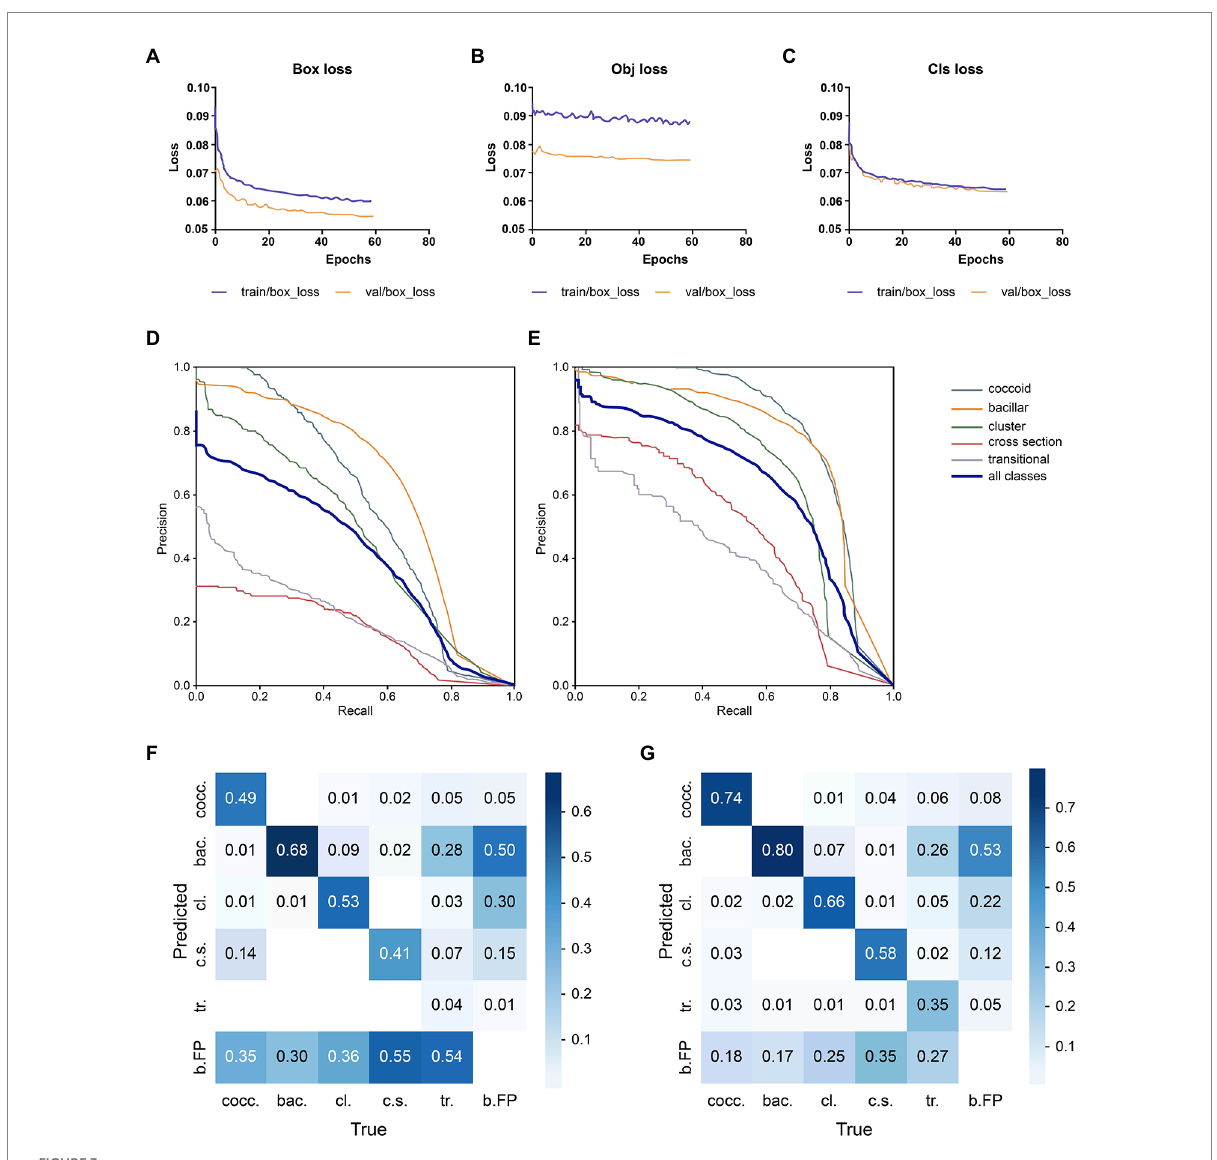
FIGURE 3 Performance comparison of the deep learning models. (A) Bounding box regression loss: assessing the degree of overlap between the prediction and real frames. (B) Confidence loss: it calculates whether the grid’s confidence is correct. (C) Classification probability loss: assessing the classification. (D) YOLO v5 PR curve: it indicates the relationship between precision and recall; rows indicate the recall, whereas columns display the prediction by the model. (E) Optimized YOLO v5 PR curve. Optimized YOLO v5’s PR curve (E) can completely wrap around YOLO v5’s PR curve (D) , indicating that Optimized YOLO v5 outperforms YOLO v5. (F) YOLO v5’s confusion matrix. The diagonal values indicate the true positive portion for each object type, and the other values, outside of the diagonal, display the misclassification rates, (G) The optimized YOLO v5’s confusion